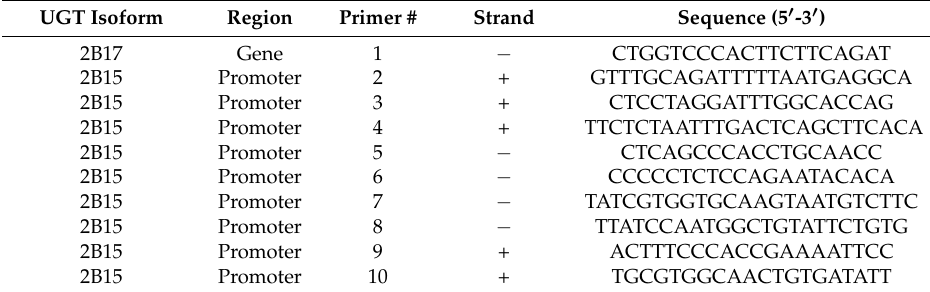
Table 3. Sequencing primers used to obtain the sequence data for the PCR reactions. The UGT isoform being examined, region of amplification, primer name, binding DNA strand, and sequence are